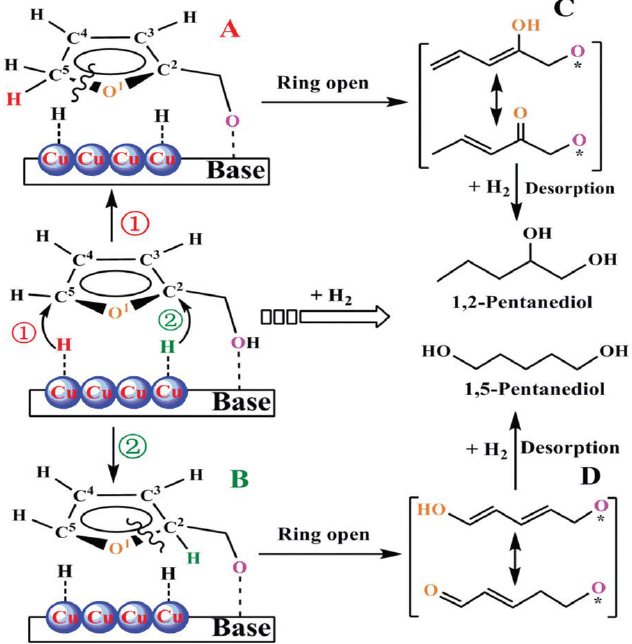
Figure 4. Reaction mechanism of furfural hydrogenolysis over CuMgAl − MMO catalysts [170]. (Copyright 2022, Royal Society of Chemistry).